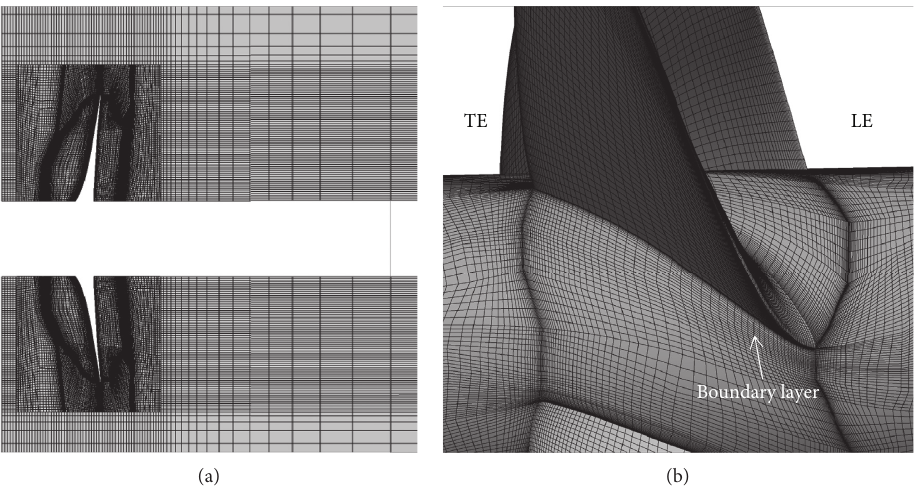
Figure 2: Grids along the propeller surface for Mesh 2. Table 1: Details of three systematically refined meshes.